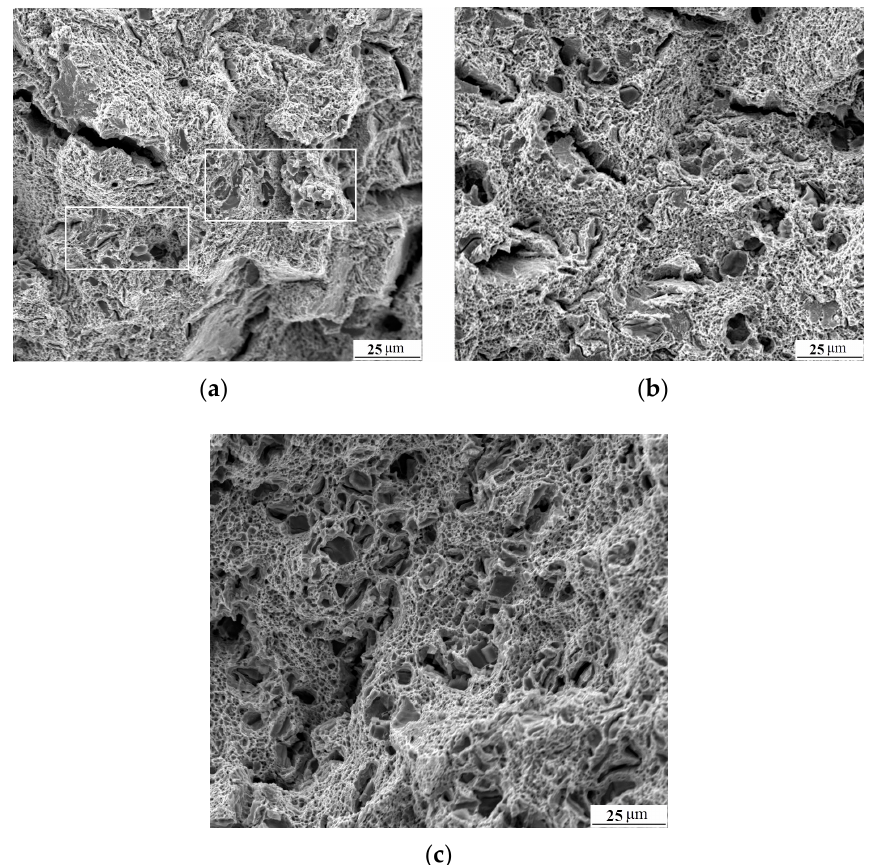
Figure 10. SEM images of tensile fracture after spheroidizing annealing: ( a ) sample No. 1; ( b ) sample No. 2; ( c ) sample No. 3.